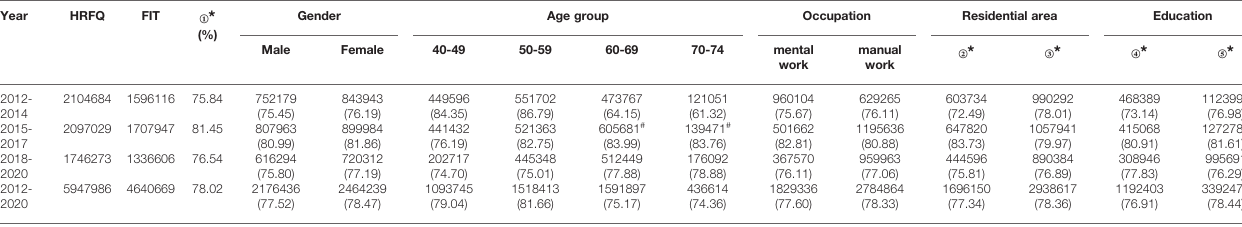
TABLE 5 | Analysis of compliance results of FIT after HRFQ,